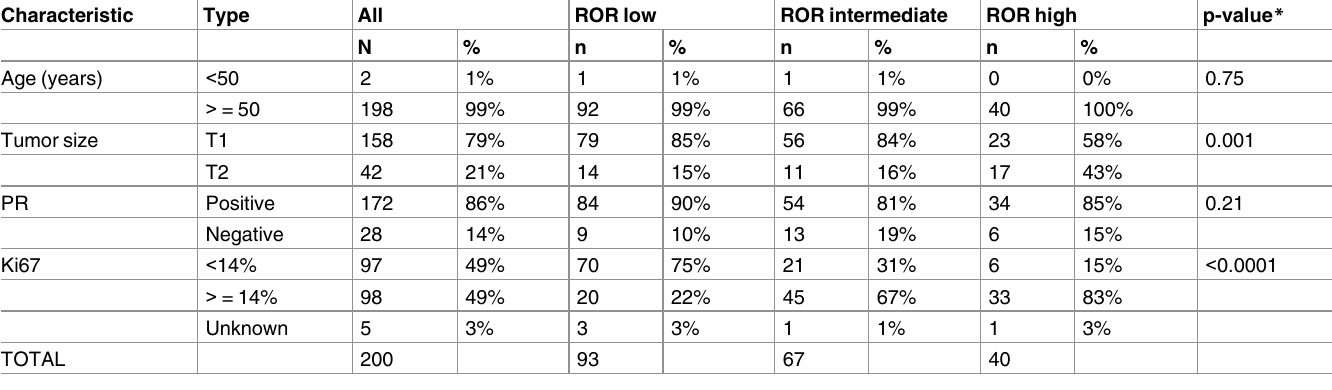
results; and Prosigna assay done at the central laboratory). Before receiving the Prosigna test results, physicians categorized subtypes by St Gallen IHC criteria as Luminal A in 126 (64%) patients and Luminal B in 70 (36%) patients. Post-Prosigna assay, these values were 111 (56.6%) Luminal A, 84 (42.9%) Luminal B, and 1 (0.5%) HER2-E. Tumor subtypes as assessed by the Prosigna test were 114 (58.2%) Luminal A, 79 (40.3%) Luminal B, 1 (0.5%) HER-2E, and 2 (1.0%) basal-like. The average percentage of Ki67 in Luminal A and Luminal B samples is shown in S1 Fig. A receiver operating characteristic (ROC) curve to predict the optimal threshold for discrimination of Luminal A and Luminal B is shown in S2 Fig. Table 1. Patient and tumor